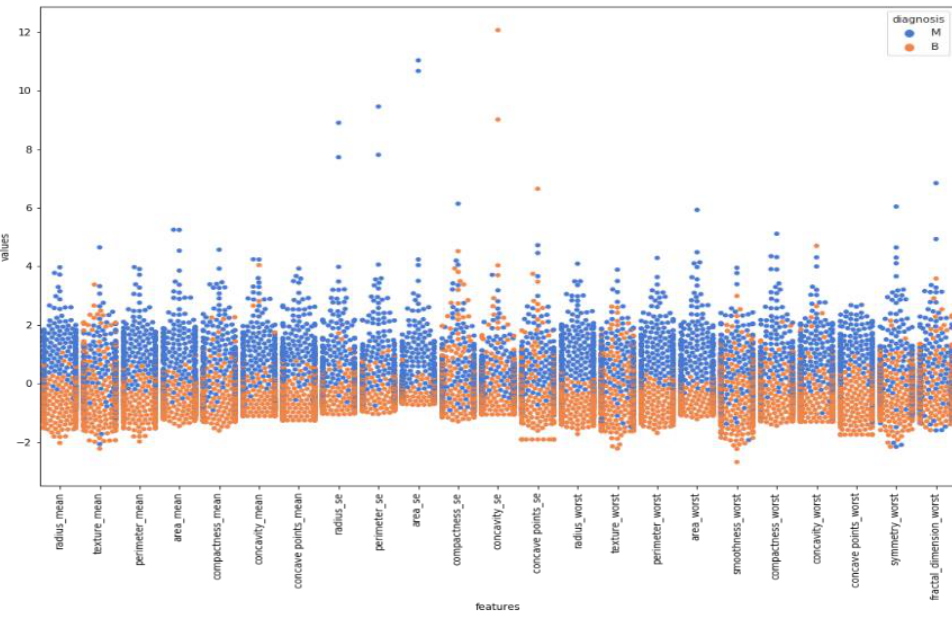
Figure 7. Swarm plot after the first elimination.